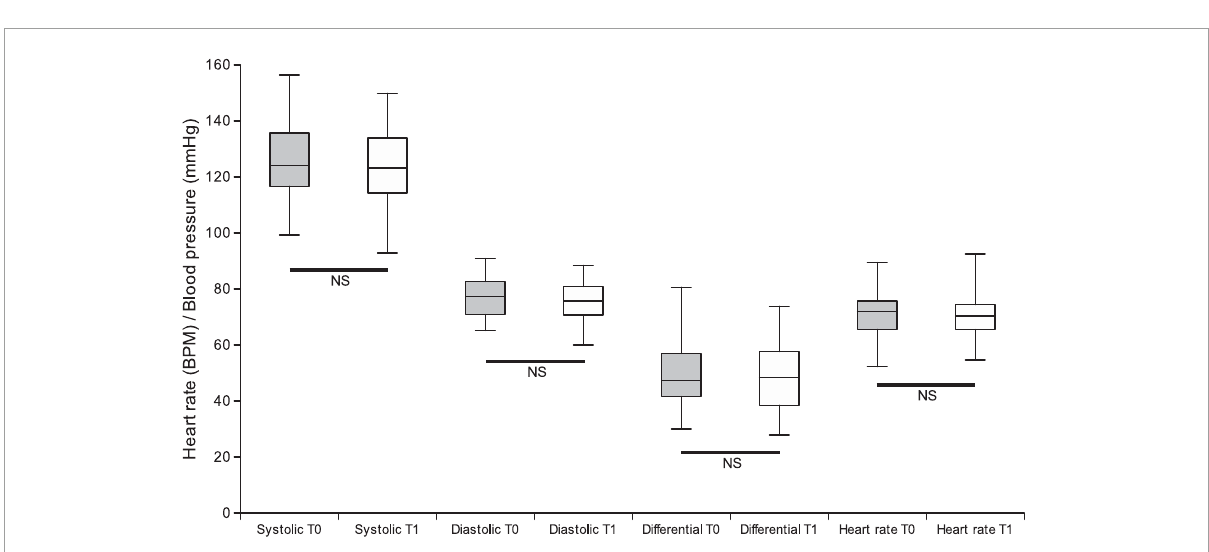
FIGURE2 Graphical representation of comparison between cardiovascular parameters: systolic arterial pressure, diastolic arterial pressure, differential arterial pressure and heart rate measured at T0 vs. T1.